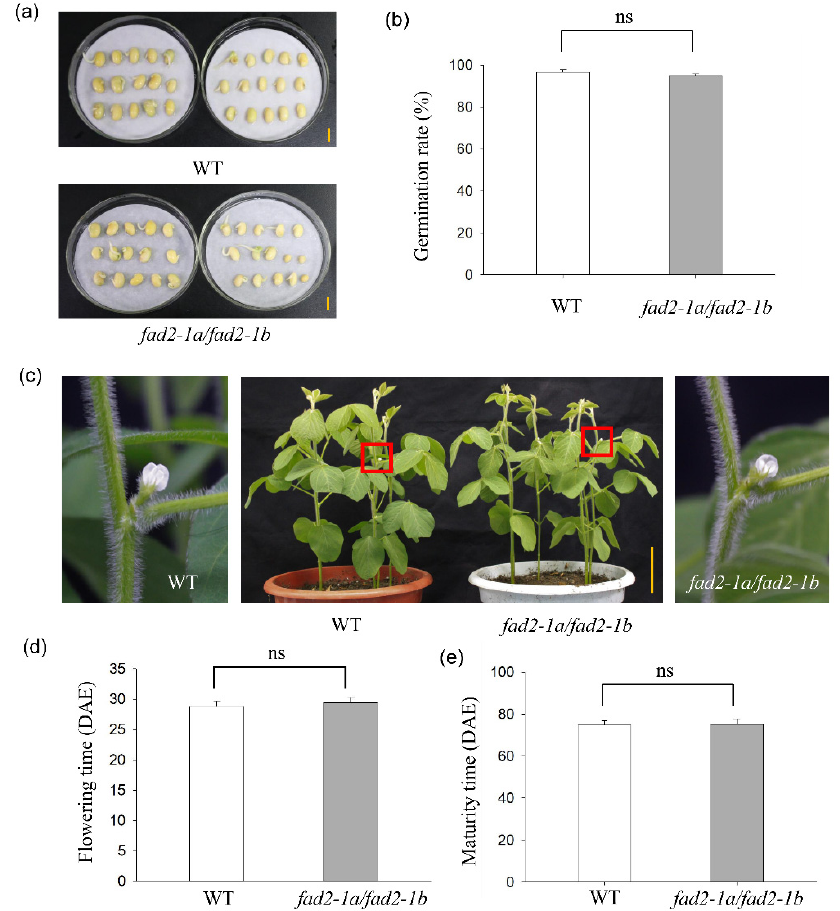
Figure 4. The phenotyping of the fad2-1a / fad2-1b mutant. ( a ) The seedlings of the wild type and fad2-1a / fad2-1b were germinated for 2 days. Scale bars = 1 cm. ( b ) The germination rate in the wild type and fad2-1a / fad2-1b. ( c ) The flowering of the wild type and fad2-1a / fad2-1b. Scale bars = 10 cm. ( d ) The flowering time in the wild type and fad2-1a / fad2-1b. ( e ) The maturity time in the wild type and fad2-1a / fad2-1b. The ns represents no significant differences.